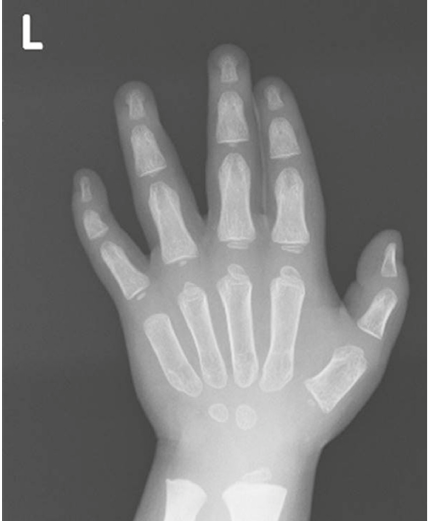
Figure 7: X-ray image of the fingers revealing sharp metacarpals.